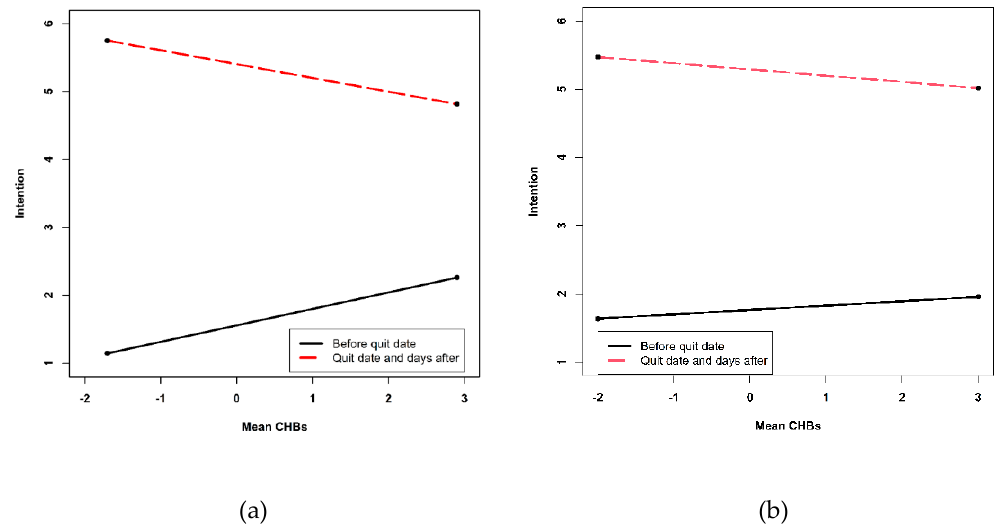
Figure 1. Simple slopes of the between-person variable of daily CHBs (mean CHBs) predicting daily intention to quit smoking before and after quit date for women ( a ) and men ( b ). The between-person variable of daily CHBs is centered so that 0 is indicating the mean CHB value of the average women.